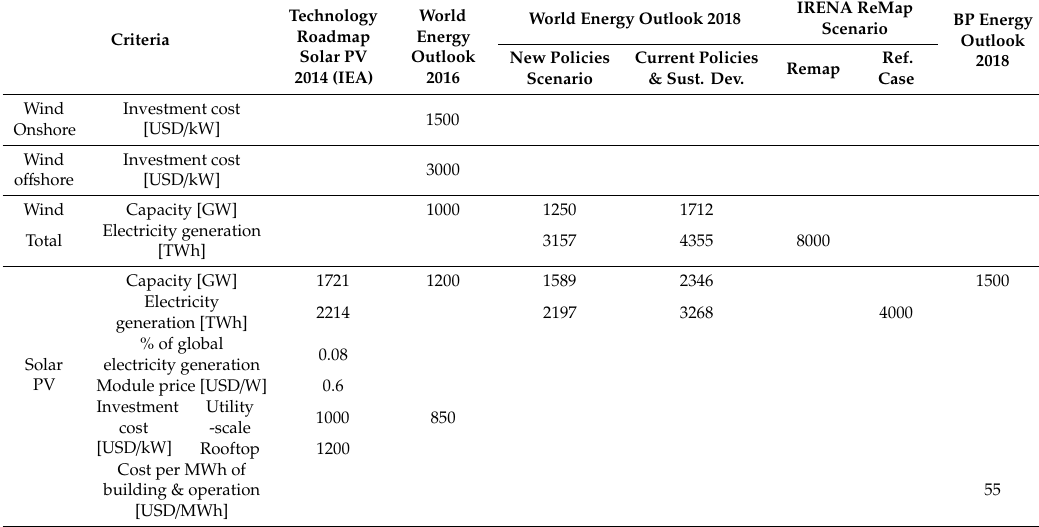
Table 2. World capacity, electricity generation and investment costs of solar PV and wind energy globally in year 2030 (sources of data: